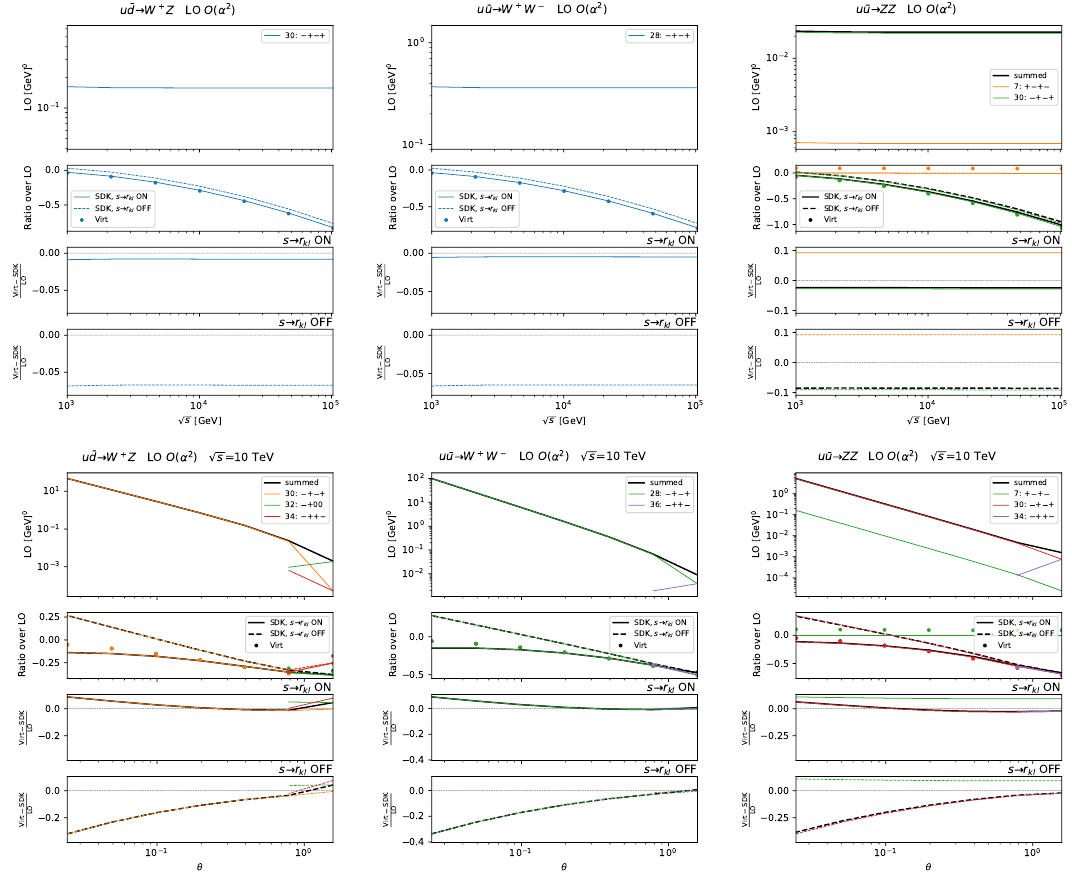
Figure 1 . Comparison between exact results (dots) for O ( (cid:11) ) NLO EW virtual corrections and their LA (lines) in the case of squared matrix elements of representative 2 ! 2 processes. Solid lines include the SSC s ! r kl contributions, while dashed lines do not. Upper plots show a scan in energy for a fixed t=s value, while lower plots a scan in the angle (cid:18) between the momenta of the first and third particle. More details are given in the